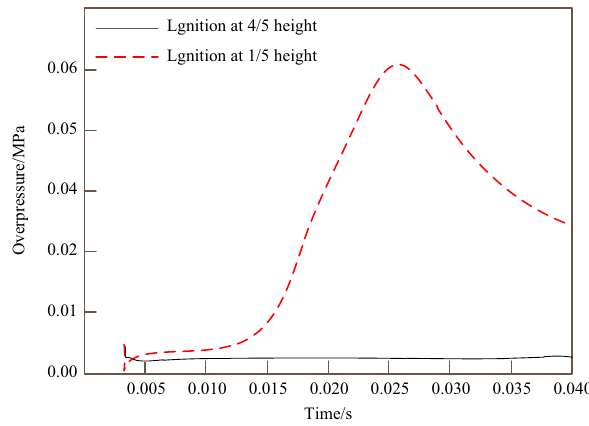
Figure 6: Overpressure – time curves ( 75% ) when the ignition point is located at the top and bottom of the tank,